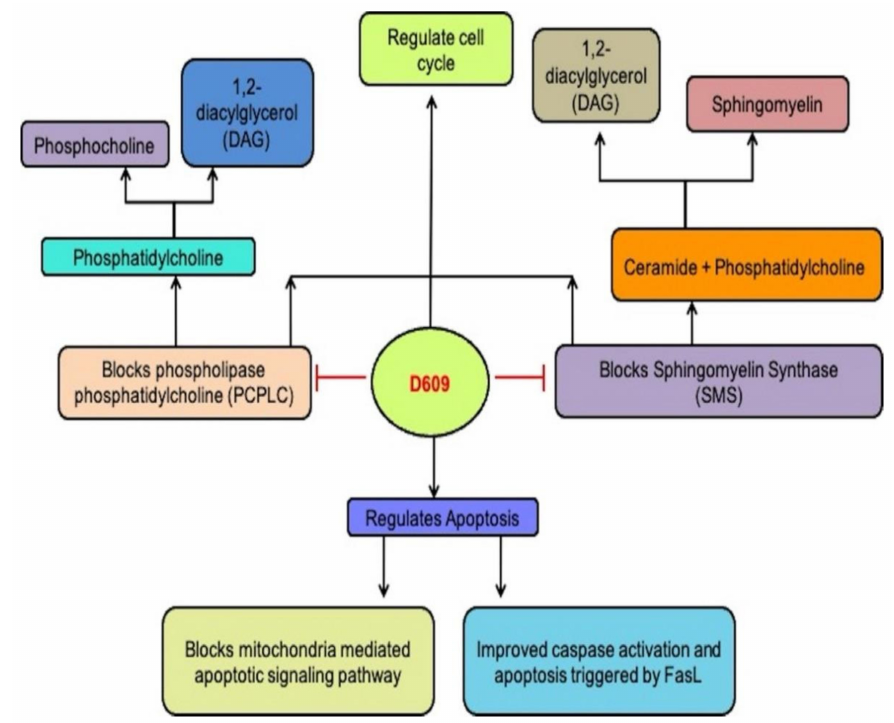
Figure 2. D609 blocks PCPLC and SMS and regulates cell cycle and